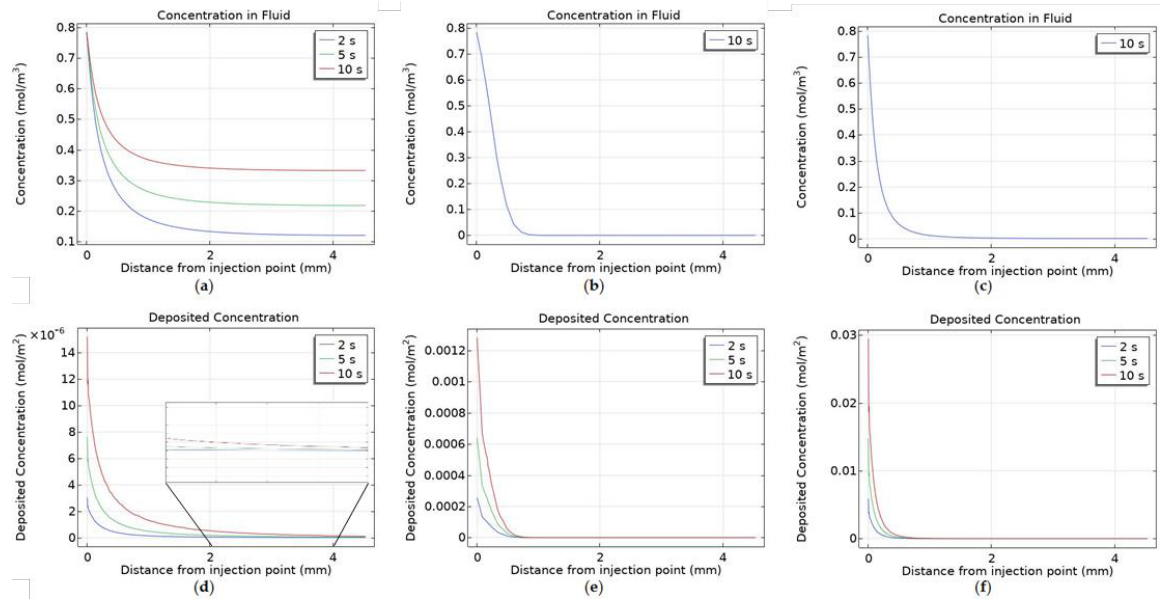
Figure 5. Concentration cut lines of nanoparticles within the fluid at the end of injection, with sur- face charge; ( a ) − 30 mV, ( b ) 0 and ( c ) +30 mV, and deposited onto cell surfaces, with surface charge; ( d ) − 30 mV ( e ) 0 and ( f ) +30 mV.